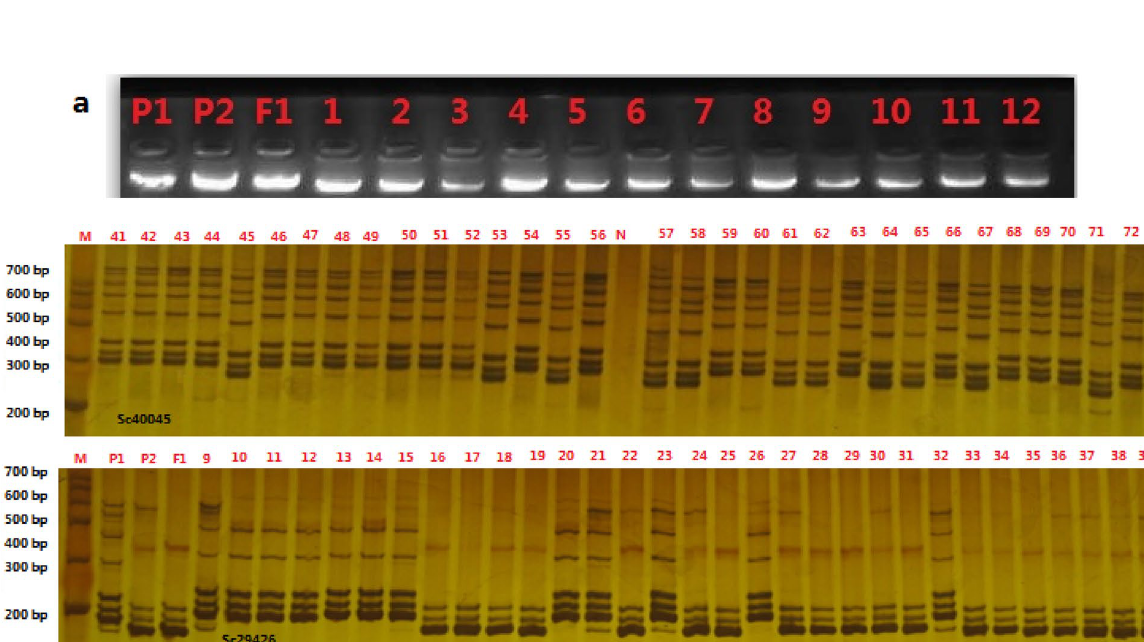
Table 2. The profile of the linkage groups based on the broccoli DH population.